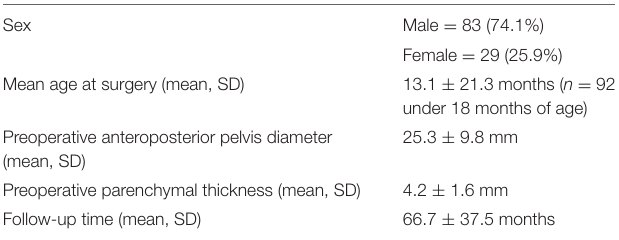
TABLE 2 | Demographics, age at surgery, preoperative ultrasound findings and follow-up time of patients who met the inclusion